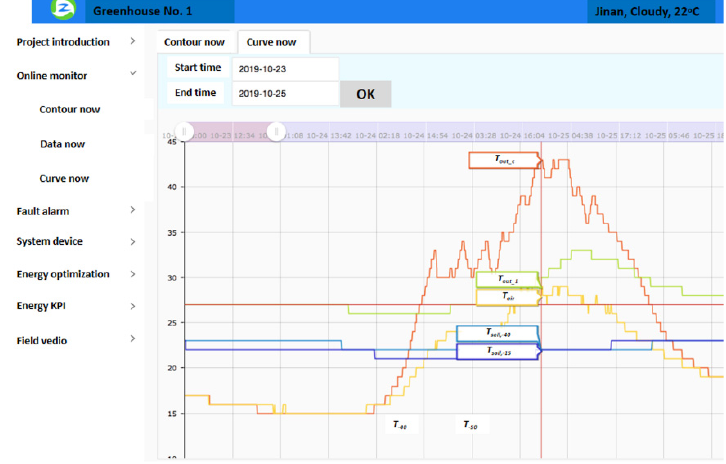
8 of 25 Table 2. Summary of the experimental instruments. Item